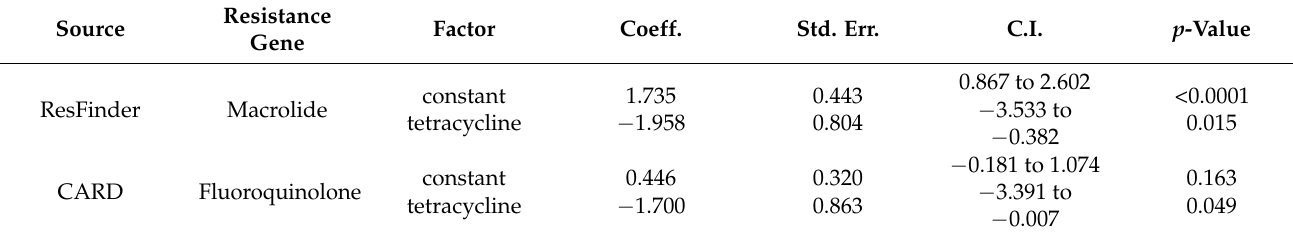
Table 1. Logistic regression analysis between genotypic resistance and resistance genes of Enterococcus spp. ( n = 49).